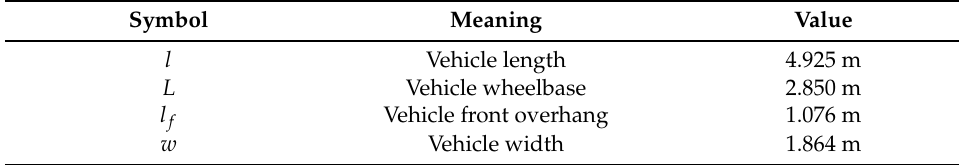
Table A2. Vehicle size parameters.